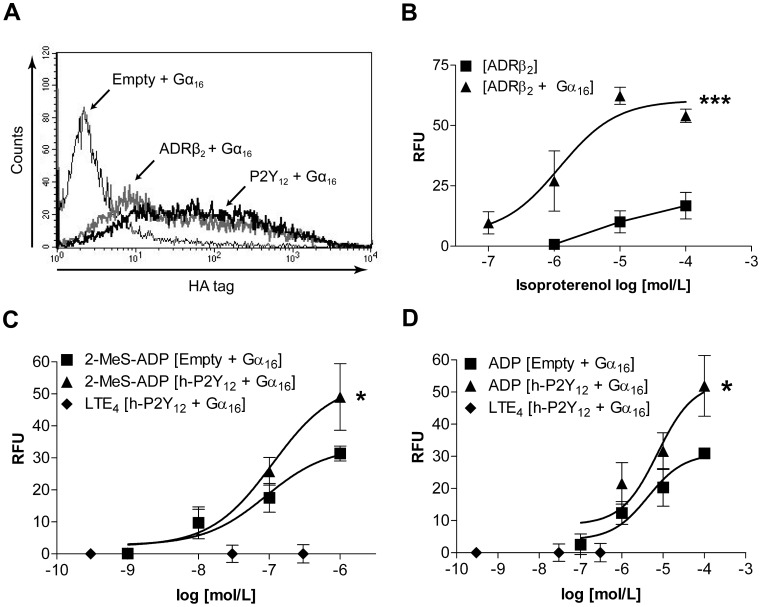
Effect of LTE4 on HEK293 cells co-transfected with h-P2Y12 and Gα16.HEK293 cells were transiently transfected with vectors indicated and intracellular responses recorded. (A) Flow cytometry analysis of ADRβ2 and h-P2Y12 protein surface expression in [ADRβ2+ Gα16] and [hP2Y12+ Gα16] transfectants respectively, representative of three experiments. ADRβ2 and h-P2Y12 were detected using an anti-HA antibody, representative of three experiments. (B) [ADRβ2] and [ADRβ2+ Gα16] transfectants stimulated with isoproterenol, N = 6, 2-way ANOVA p = 0.0003. [h-P2Y12+ Gα16] and [Empty+Gα16] transfectants stimulated with LTE4 and either (C) 2-MeS-ADP or (D) ADP, N = 9. 2-way ANOVA between (C) 2-MeS-ADP responses p = 0.0190 and (D) ADP responses p = 0.0220. Results (B), (C) and (D) presented as peak intracellular calcium response mean ± S.E.M.